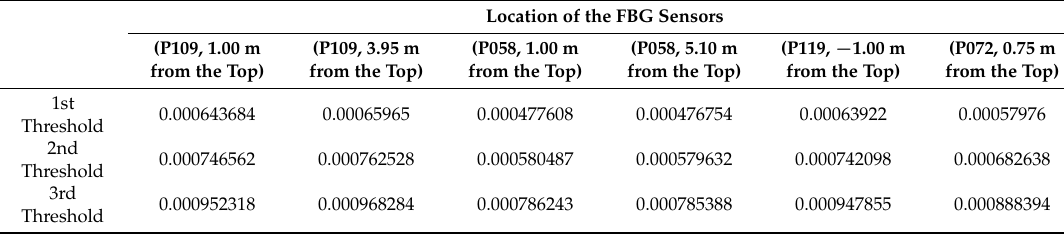
Table 10. Calculated thresholds for the FBG sensors.